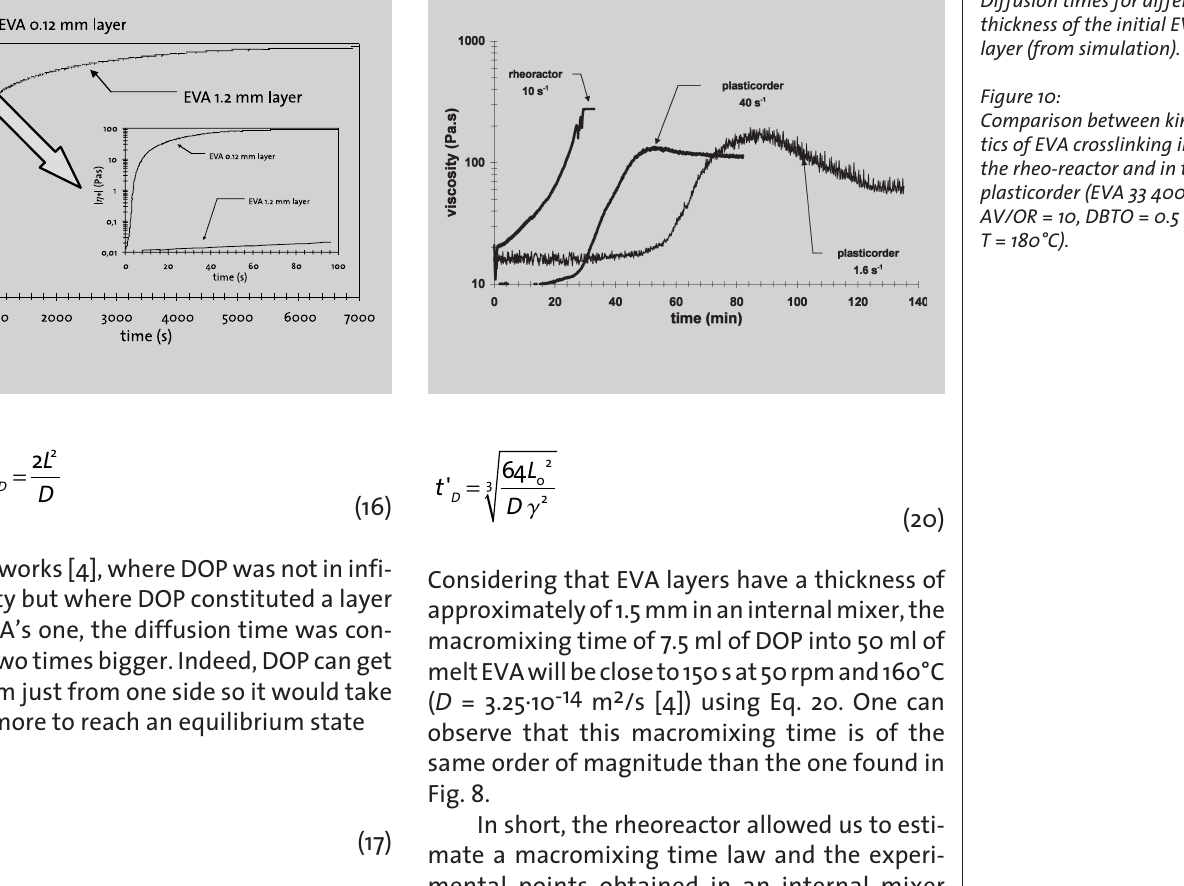
Figure 9 (left): Diffusion times for different thickness of the initial EVA layer (from simulation). Figure 10: Comparison between kine- tics of EVA crosslinking in the rheo-reactor and in the plasticorder (EVA 33 400, AV/OR = 10, DBTO = 0.5 phr, T =